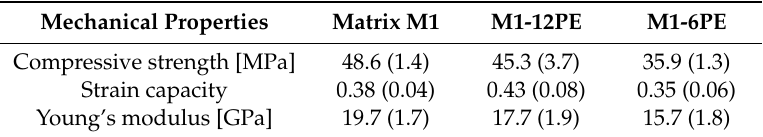
Table 3. Mechanical properties of the matrix and SHCC mixtures obtained in quasi-static compression tests (standard deviations are given in parentheses).